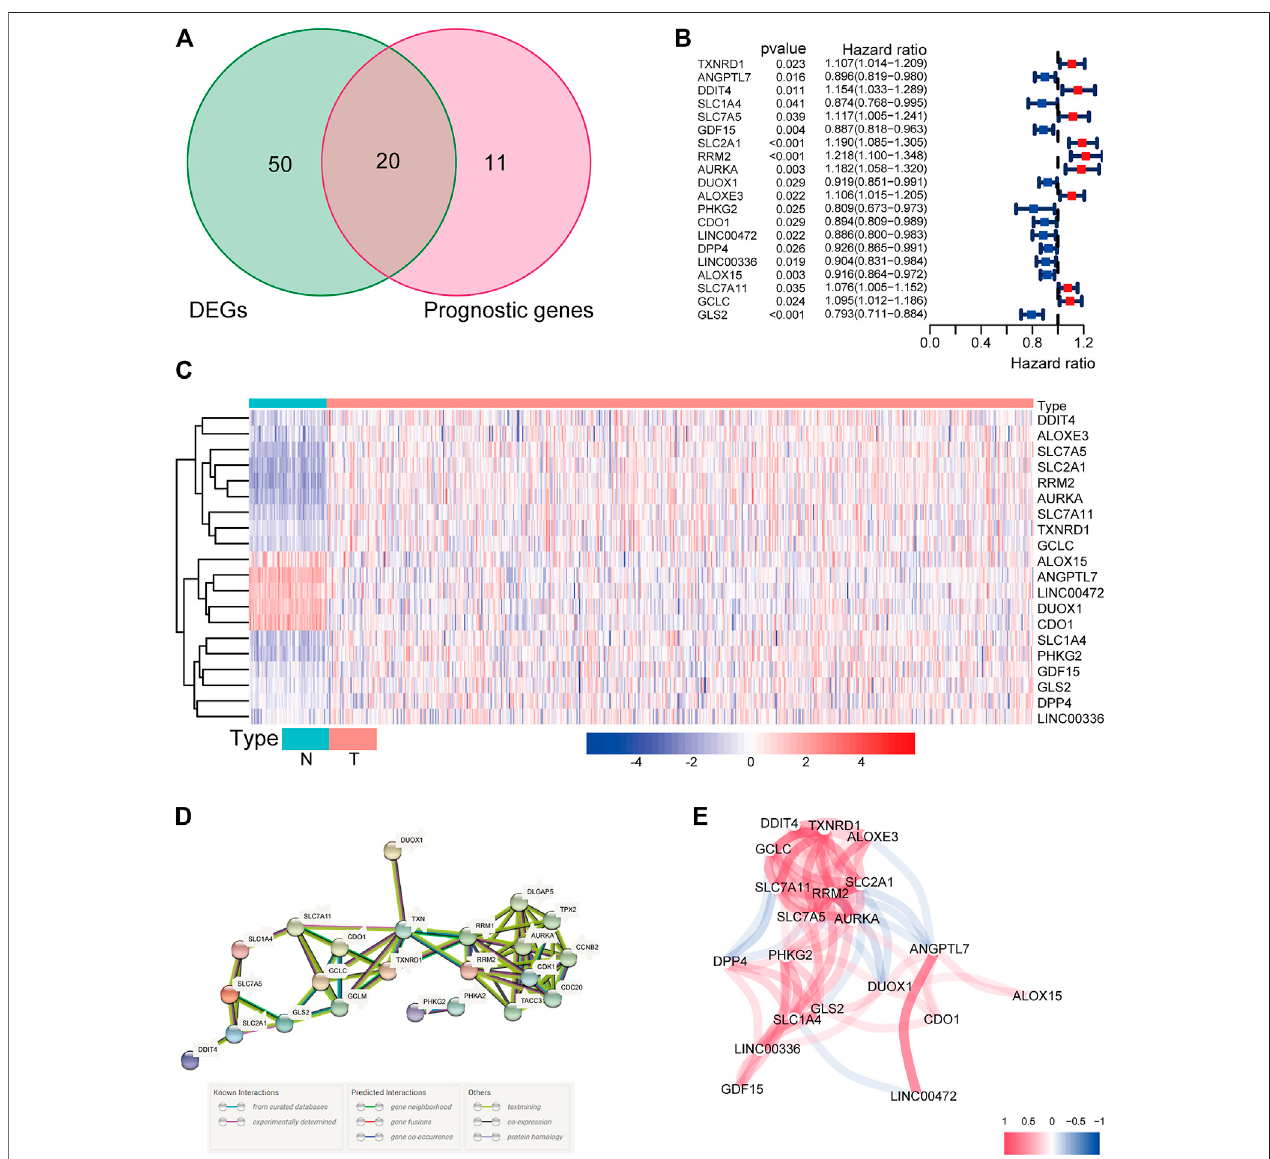
FIGURE 1 | (A) Venn diagram to identify differentially expressed genes between tumor and adjacent normal tissue that were correlated with OS. (B) Forest plots showing the results of the univariate Cox regression analysis between gene expression and OS. (C) The expression of these 20 overlapping genes in tumor tissue and normal tissue. (D) The PPI network downloaded from the STRING database indicated the interactions among the candidate genes. (E) The correlation network of candidate genes. The correlation coef fi cients are represented by different